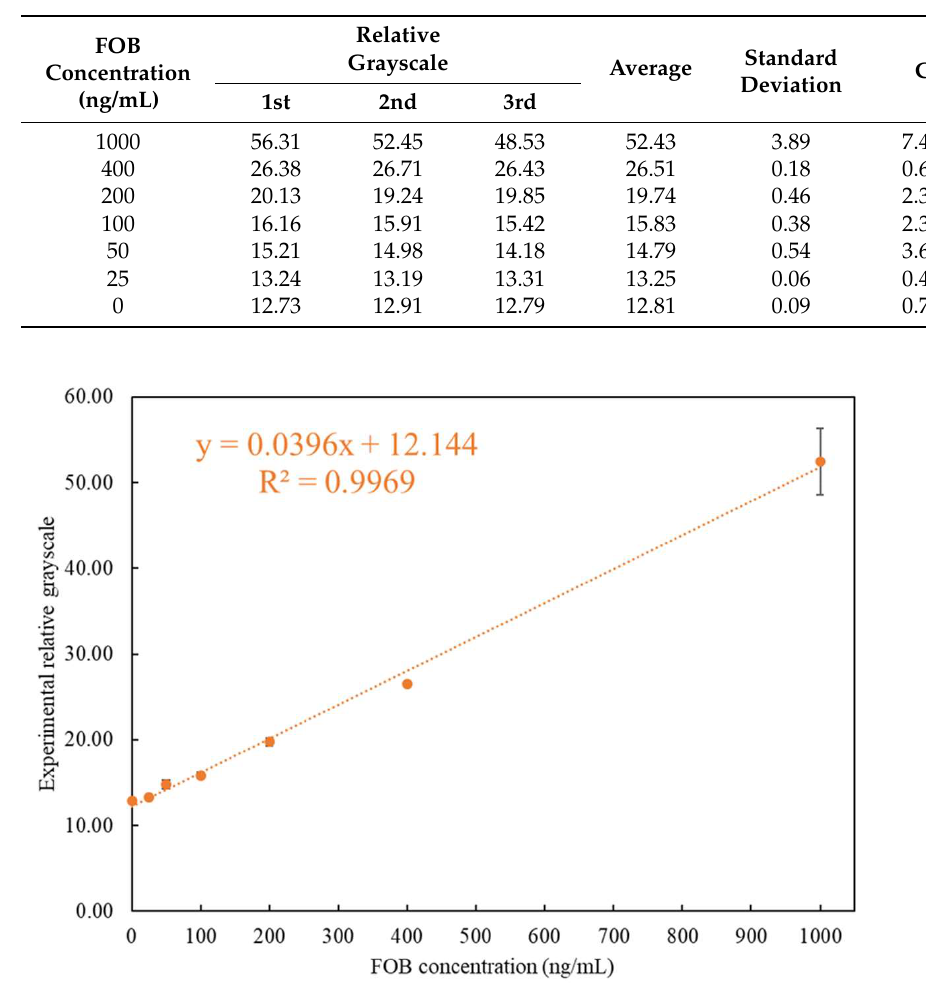
Figure 8. Relationship between the detected experimental grayscales and different concentrations of FOB.